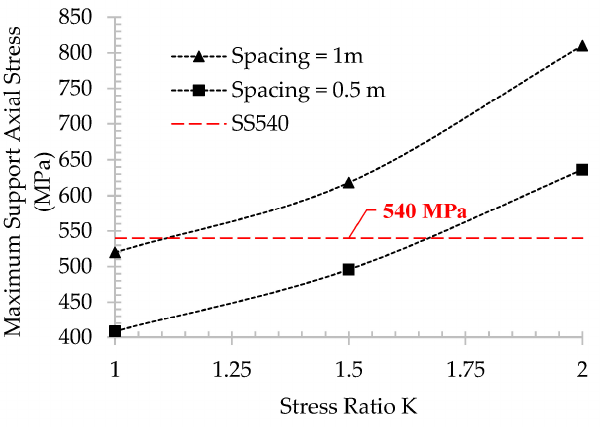
Figure 13. Maximum support axial stress for 150 m of depth.